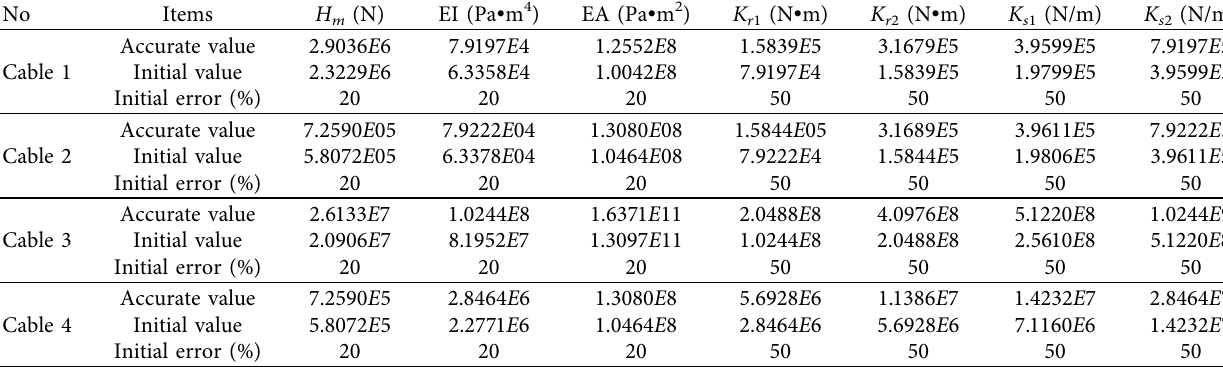
Table 2: Accurate and initial values of system parameters of the four cables.